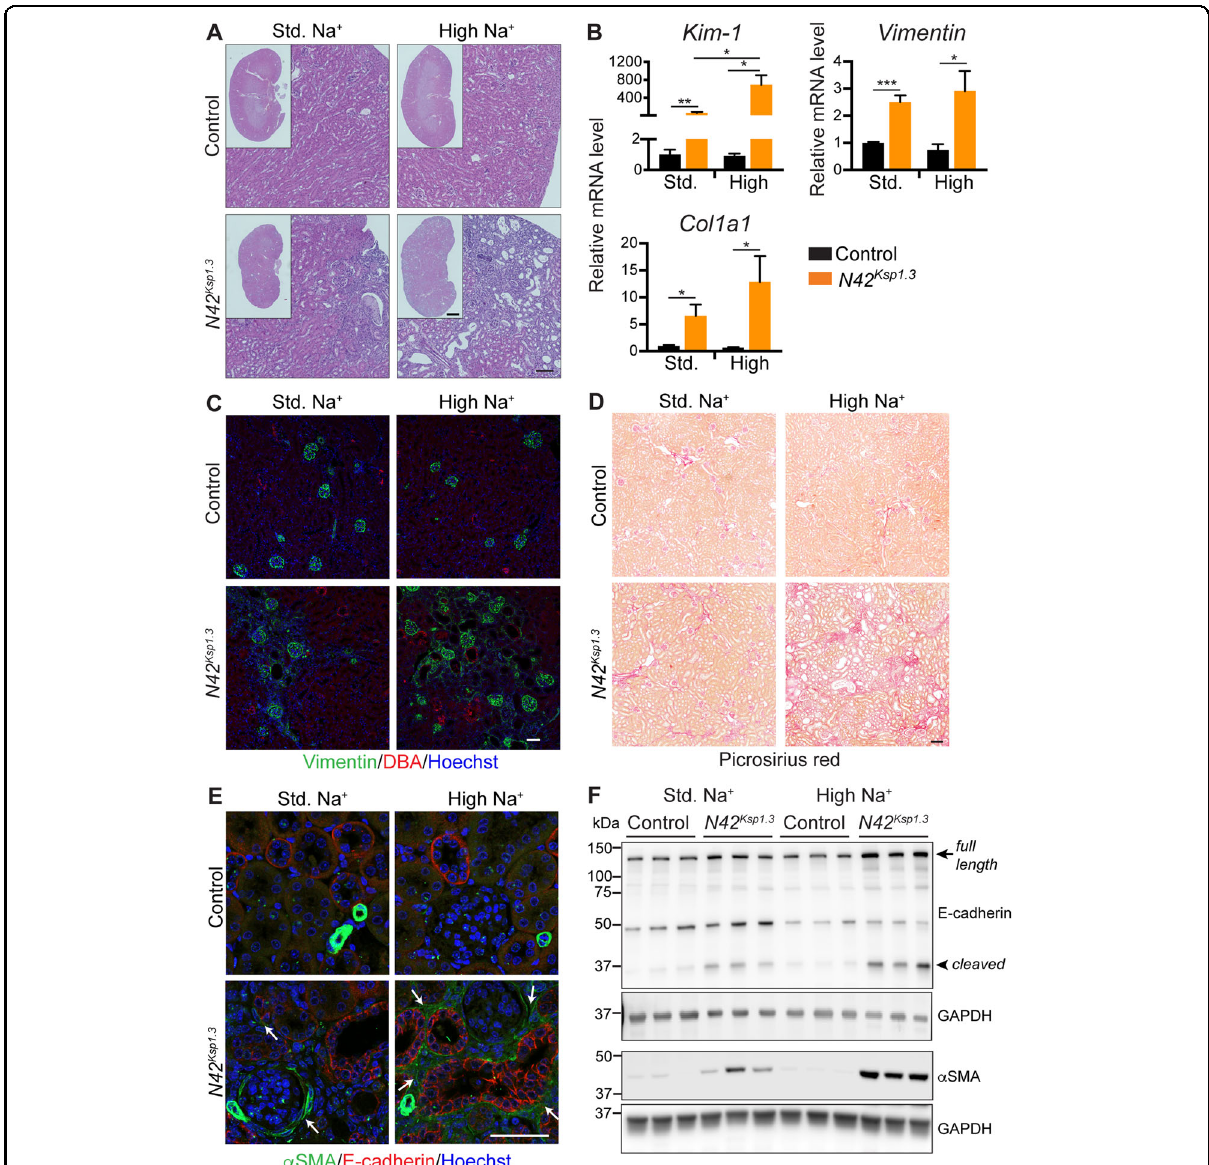
E Immunostaining of α SMA (green) and E-cadherin (red). DNA is stained by Hoechst (blue). Arrows indicate regions of α SMA positive interstitium. Scale bar: 50 μ m. F Immunoblot analysis of E-cadherin and α SMA with GAPDH as a loading control. Arrow indicates full-length E-cadherin, the arrowhead is 30 kDa cleaved form. Data in B presented as means ± SEM and signi fi cance determined using unpaired two-tailed Student ’ s t test, n